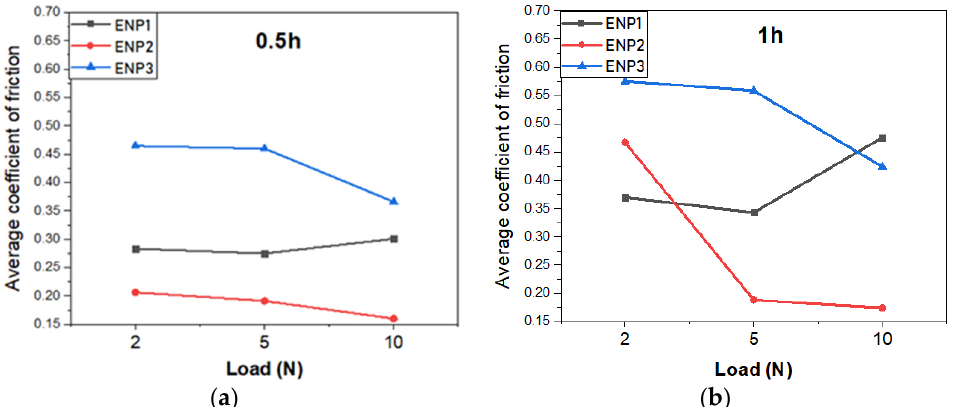
Figure 7. Influence of PTFE content on the average CoF values of the deposited electroless ENP+PTFE: ENP1, ENP2 and ENP3 duplex coatings at different loads.